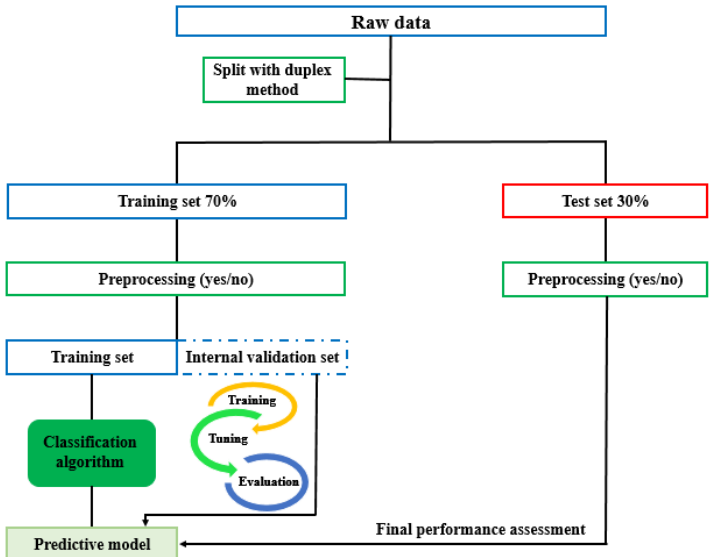
Figure 1. Data analysis pipeline.